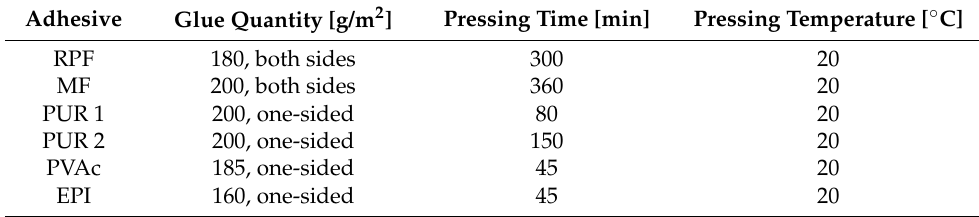
Table 2. List of adhesives and parameters